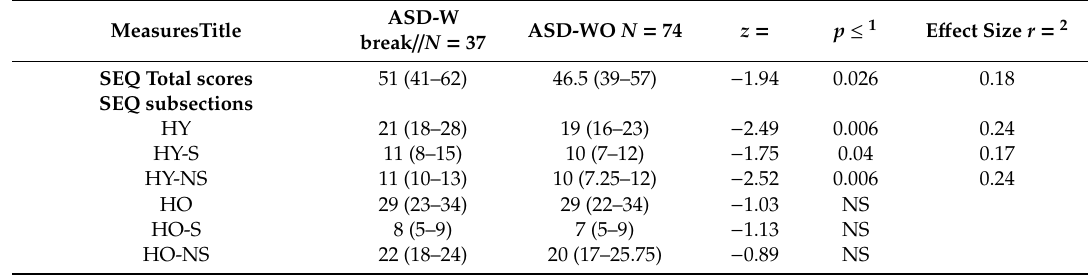
Table 2. Scores obtained from ASD-W and ASD-WO subgroups at the SSP and SEQ, expressed as medians and interquartile